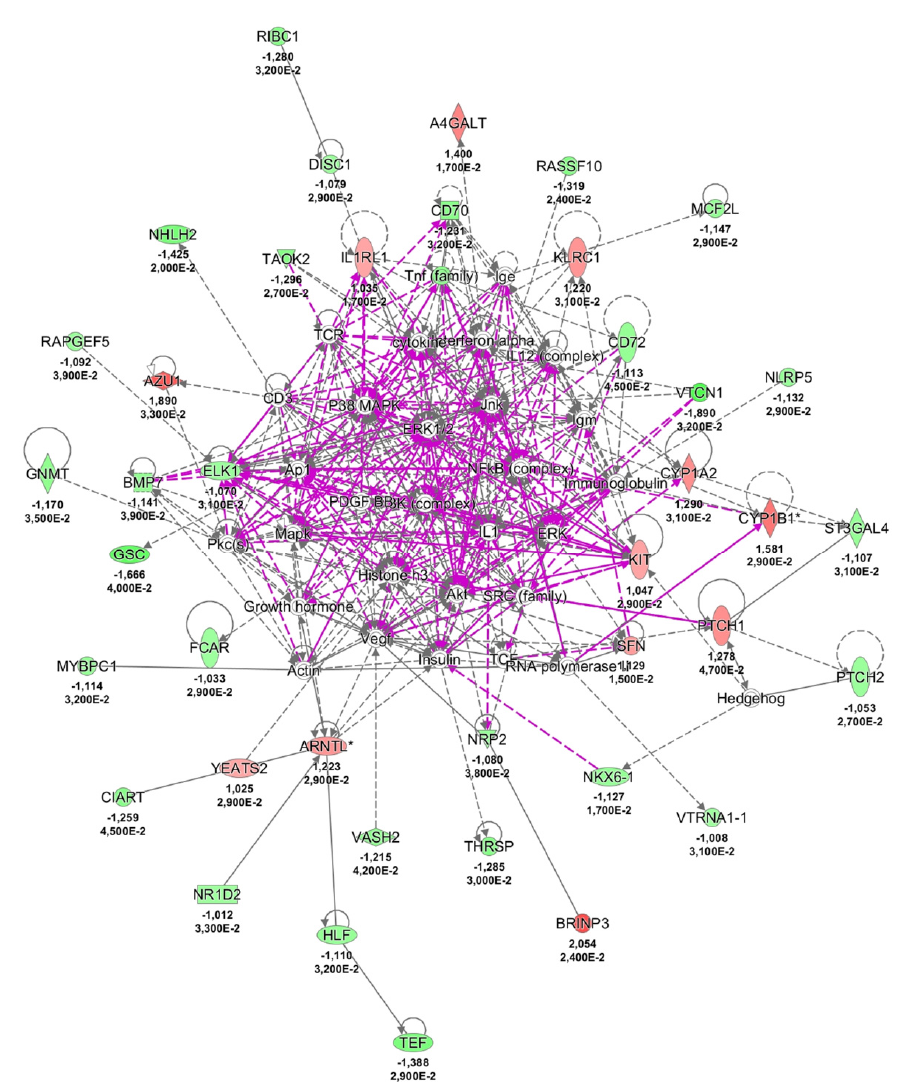
Figure 4. Ingenuity pathway analysis (IPA) networks associated with NCWS status. Transcripts are indicated by gene names, whereas shapes indicate gene functions. Lines connecting the nodes indicate known relationships between genes. Green and red colours indicate the up- and down-regulated genes,